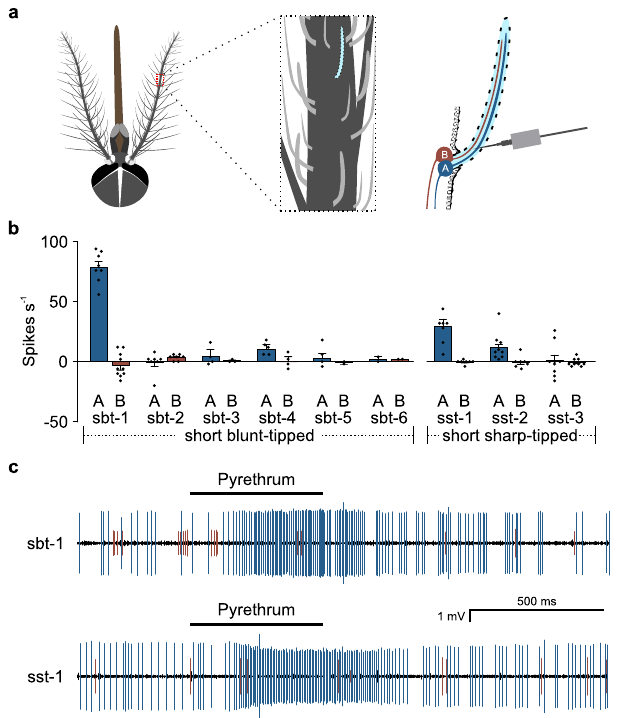
Fig. 2 Identi fi cation of pyrethrum-responsive sensilla in Ae. aegypti antennae. a A schematic drawing illustrating single sensillum recording (SSR) from Ae. aegypti mosquito antennae. b SSR responses of short sharp- tipped (sst) and short blunt-tipped (sbt) sensilla to pyrethrum (10 − 2 v v − 1 ) ( n = 8 sensilla for sbt-1; n = 7 for sbt-2, sst-1 and sst-2; n = 3 for sbt-3 and sbt-4; n = 2 for sbt-5 and sbt-6; n = 9 for sst-3). c Representative SSR traces indicating increased fi ring of A neurons of sbt-1 sensilla ( n = 8 sensilla) or sst-1 sensilla ( n = 7 sensilla) in response to pyrethrum (10 − 2 v v − 1 ) in Rockefeller mosquitoes. Data are plotted as mean ± s.e.m. and dots denote the value of each repeat.